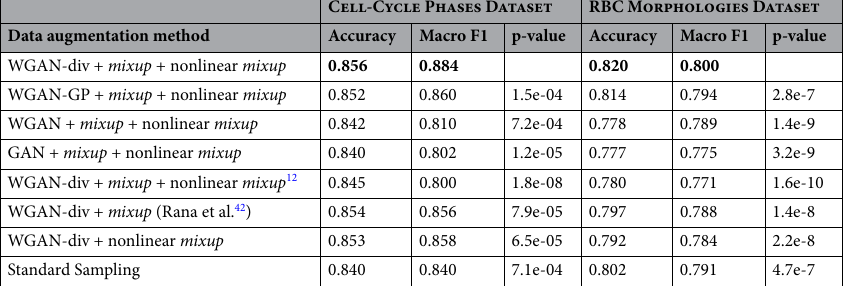
Table 2. Ablation study of each component (WGAN-div, mixup , nonlinear mixup and minority class focussed sampling). Performance comparison between different GAN models, sampling approaches and nonlinear mixup . p -values smaller than 0.01 implies the higher statistical significance of the proposed method than the compared